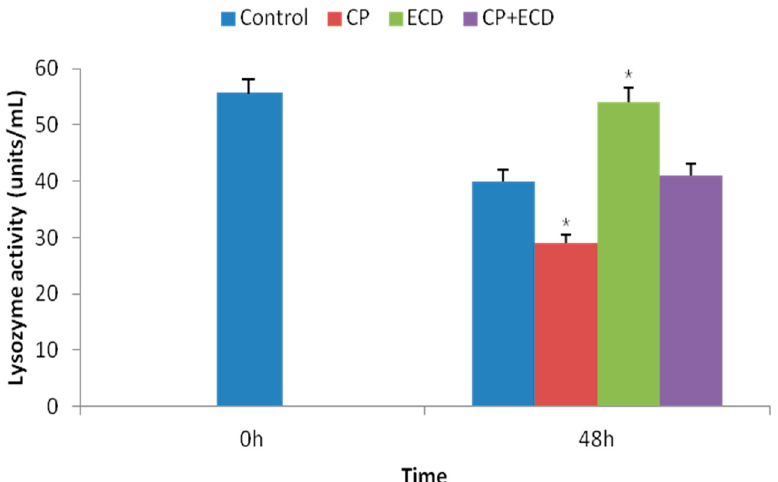
Figure 4. Effect of acute water-salinity stress for 48 h on the activity of lysozyme in the abalone ( H. discus ) after feeding on the experimental diets supplemented with CP (6%), ECD (6%), and CP + ECD (3% + 3%) for 12 weeks. Vertical bars represent the SE of the means of three experiments. * p < 0.05 for control level at 48 h.